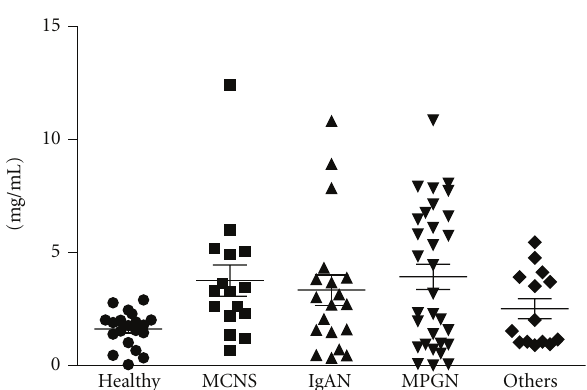
Figure 1: The serum concentrations of MBL were measured in 20 healthy controls and in 80 patients of primary glomerular diseases. The mean levels of MBL showed no statistical di ff erence between each disease. However, some cases of primary glomerulonephritis presented higher concentrations of MBL compared with healthy controls. Abbreviations. MCNS, minimal change nephrotic syn- drome ( n = 16); IgAN, IgA nephropathy ( n = 19); MPGN, membranoproliferative glomerulonephritis ( n = 31); others ( n =